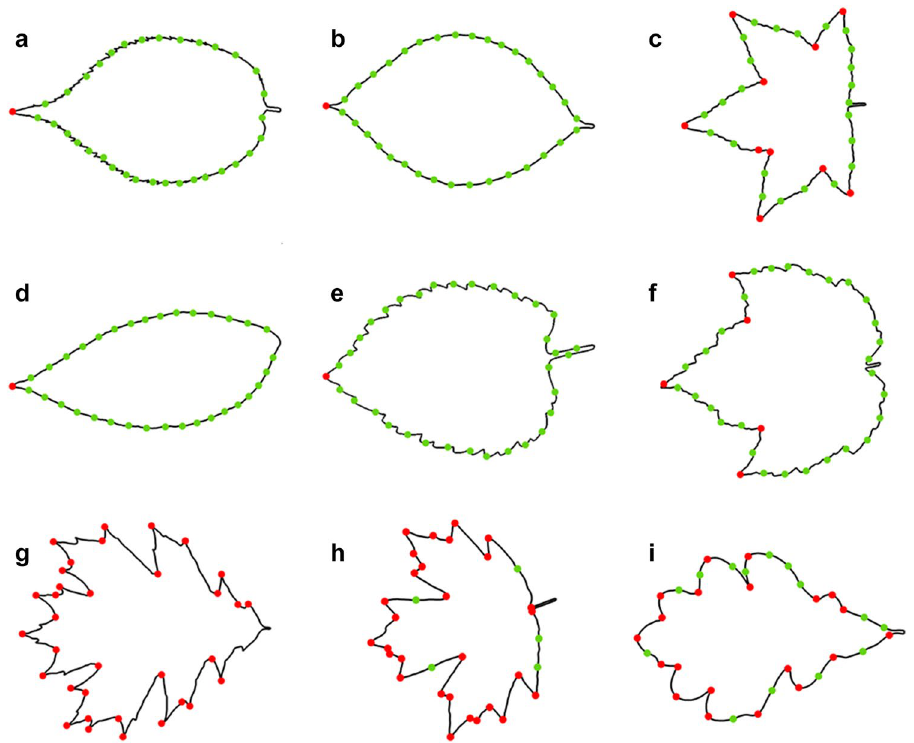
Figure 9. The original apices (red circles) and supplementary segmentation points (green circles) on leaf contours. ( a ) Cherry, ( b ) Dogwood, ( c ) Gum, ( d ) Hickory, ( e ) Mulberry, ( f ) Red maple, ( g ) Red oak, ( h ) Sugar maple, ( i ) White oak. For each group, the sample that contains the most original apices is